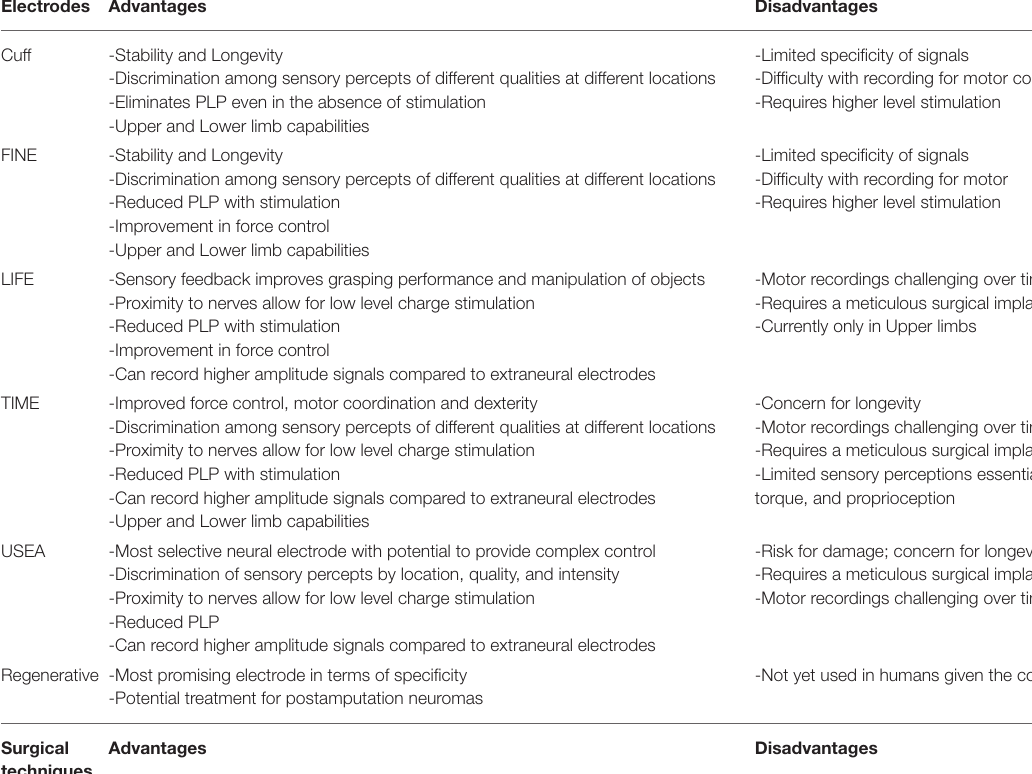
TABLE 2 | Advantages and disadvantages for prosthetic application. Electrodes